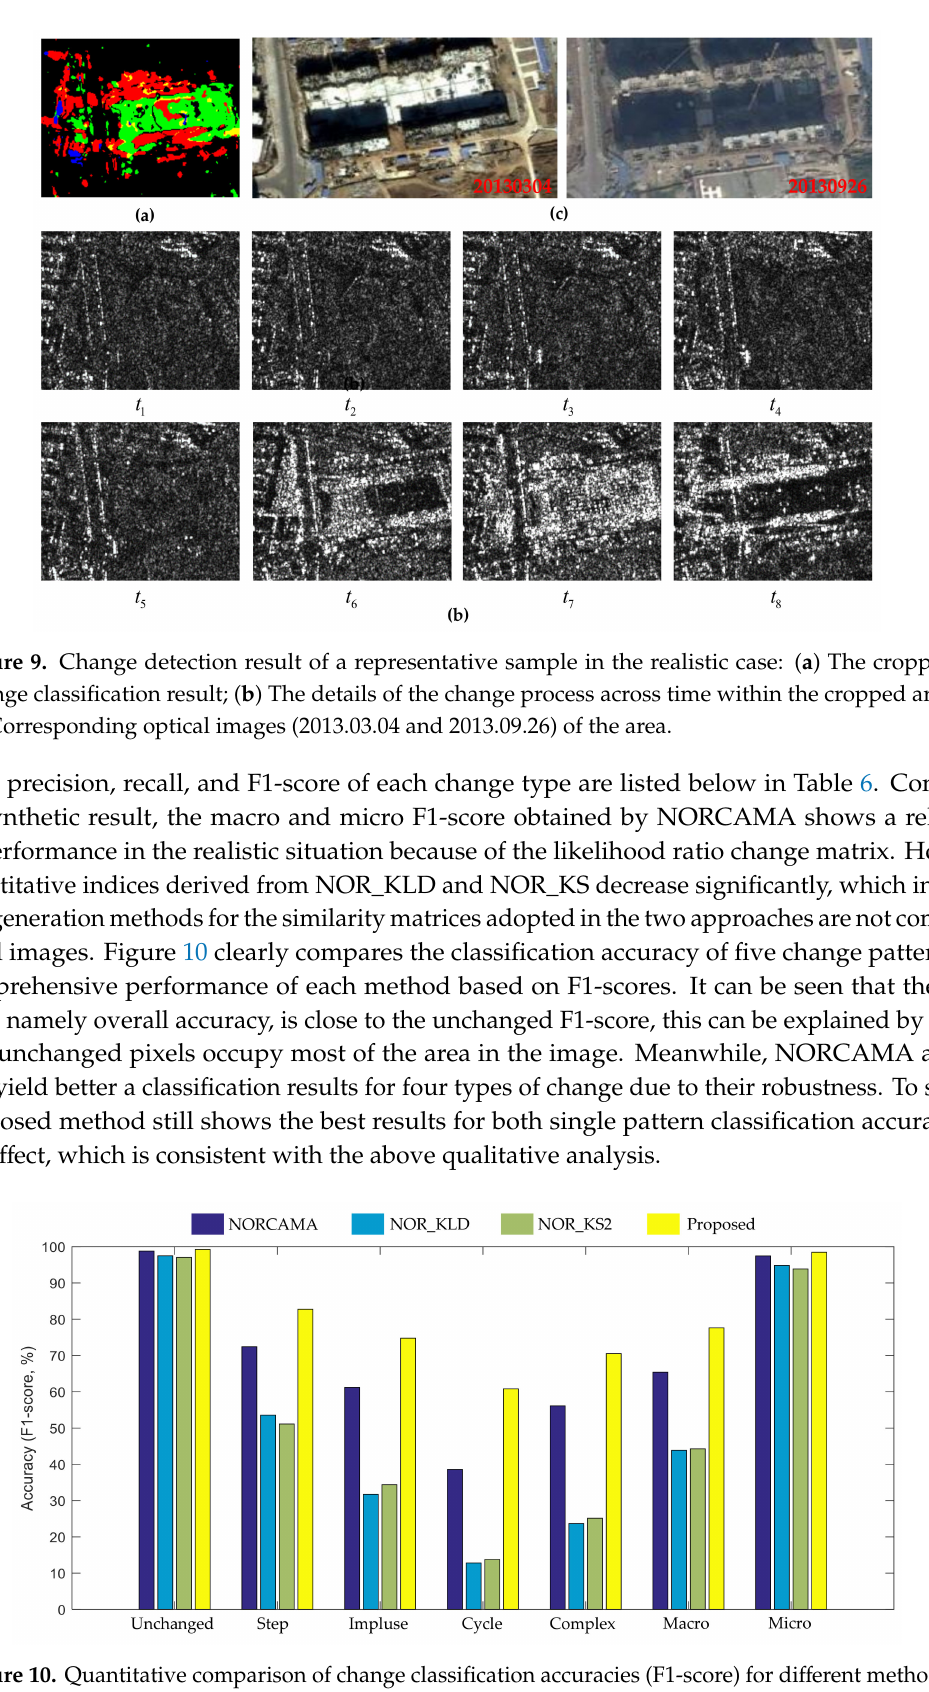
Figure 10. Quantitative comparison of change classification accuracies (F1-score) for di ff erent